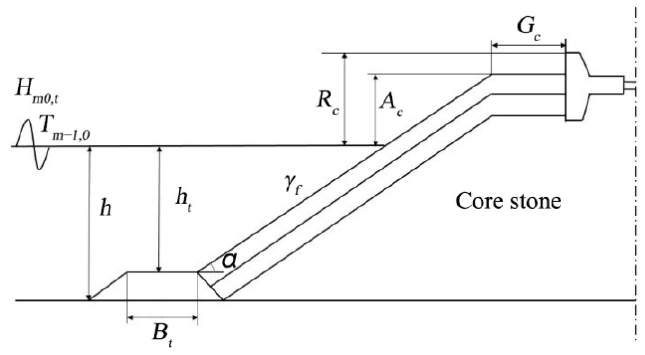
5 of 15 Figure 4. Distribution of all datasets. 3. Method 3.1. The Principles of the BP Algorithm The BP (backpropagation) neural network algorithm is a multi-layer feedforward network trained according to the error backpropagation algorithm[28]. By optimizing the function weight, the corresponding error is propagated to form a three-layer network, which has an input layer, a hidden layer, and an output layer [29]. In order to develop a BP neural network, the first step is to determine the number of layers and number of neu- rons contained in each layer. The learning principle is through gradient descent and con- tinuously adjusts to the weighting parameter 𝑋 and threshold parameter 𝑏 by applying the backpropagation algorithm to minimize the mean square error. Suppose that 𝑋 = [𝑥 (cid:2869) , 𝑥 (cid:2870) , ⋯ , 𝑥 (cid:3014) ] is used as the input space and 𝑌 = [𝑌 (cid:2869) , 𝑌 (cid:2870) , ⋯ , 𝑌 (cid:3037) ] is used as the output space. The function expression for this network’s forward propagation output is 𝑌̑ = 𝑓 (cid:3050),(cid:3029) (𝑋)(𝑤, 𝑏 ∈ 𝑅 (cid:3041) ) . The process of network training is to continuously ad- just the value of 𝑤 and 𝑏 based on the training sample set’s backpropagation algorithm and minimize the value of the defined loss parameter 𝐿𝑜𝑠𝑠(𝑌, 𝑓 (cid:3050),(cid:3029) (𝑋)) . 3.2. Details of the BP Algorithm Implementation Since there are many parameters involved in wave overtopping processes, it is diffi- cult to describe all of them. Given the structural features of single-slope breakwaters, 10 data were selected as input parameters for the network, including wave element and